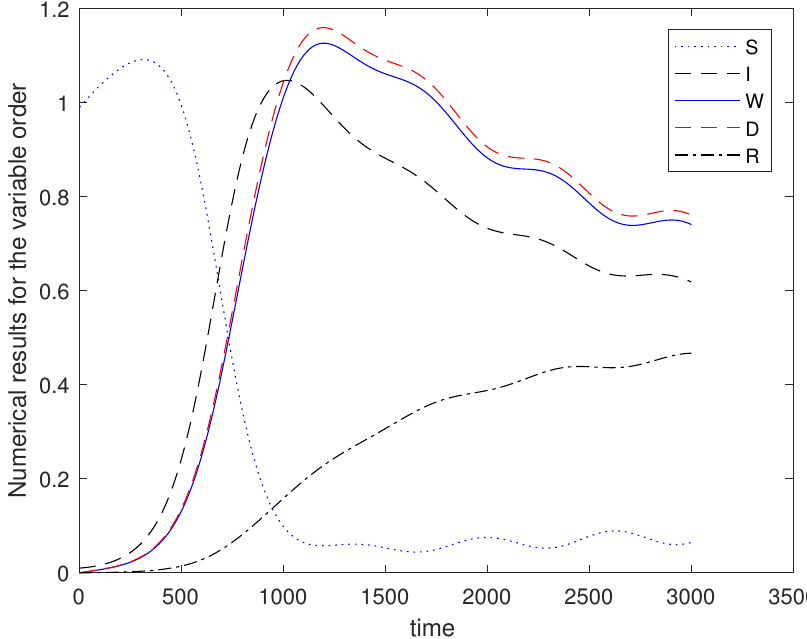
Figure 6. Numerical solution of the mathematical model (17) for the variable order 1 − 0.006 ∗ ( sin ( t ))